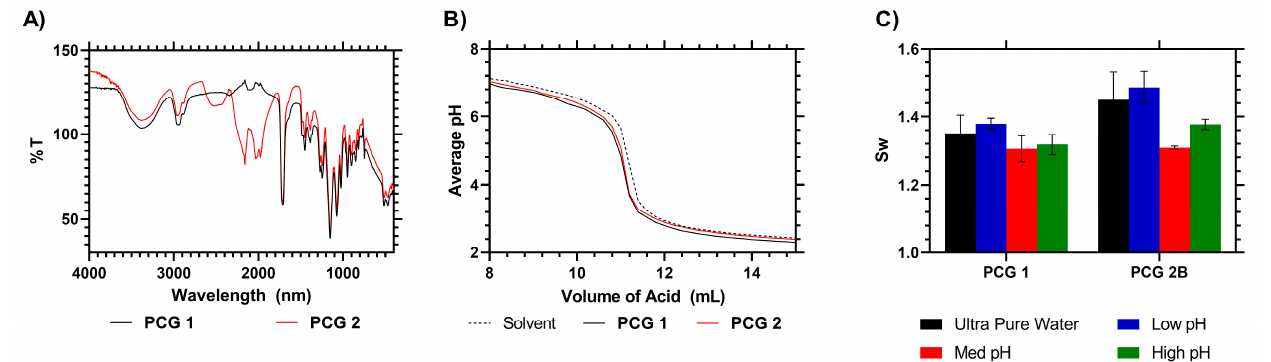
Figure 2. ( A ) IR analysis of HEMA + RAFT–HEMA films. ( B ) Raw titration data of